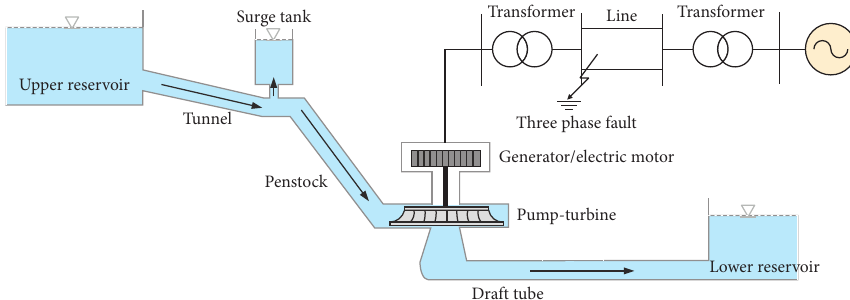
Figure 3: Structure of PSP and its interconnected infinite bus.